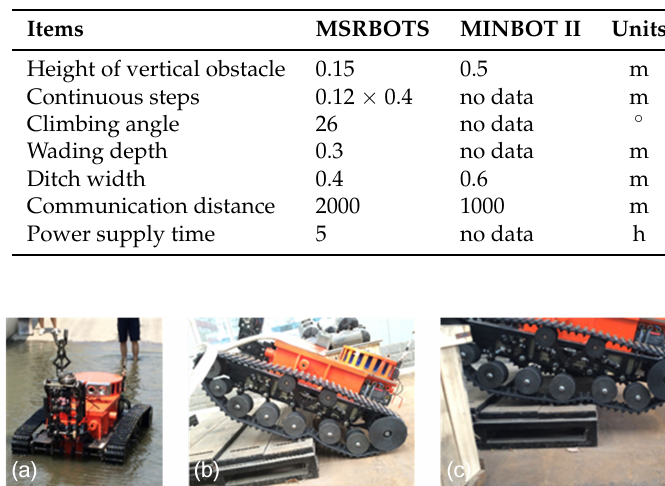
Table 3. The MSRBOTS testing results.